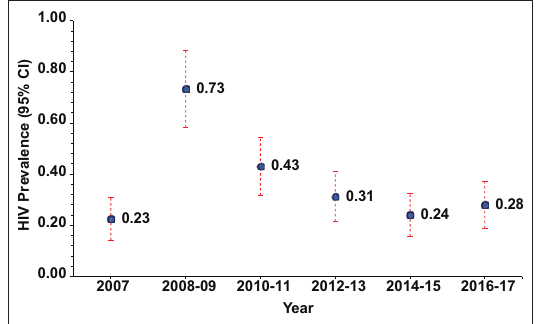
Figure 1: HIV Prevalence among pregnant women attending ANC clinics in Odisha in the last six rounds of HIV Surveillance Survey (2007 –